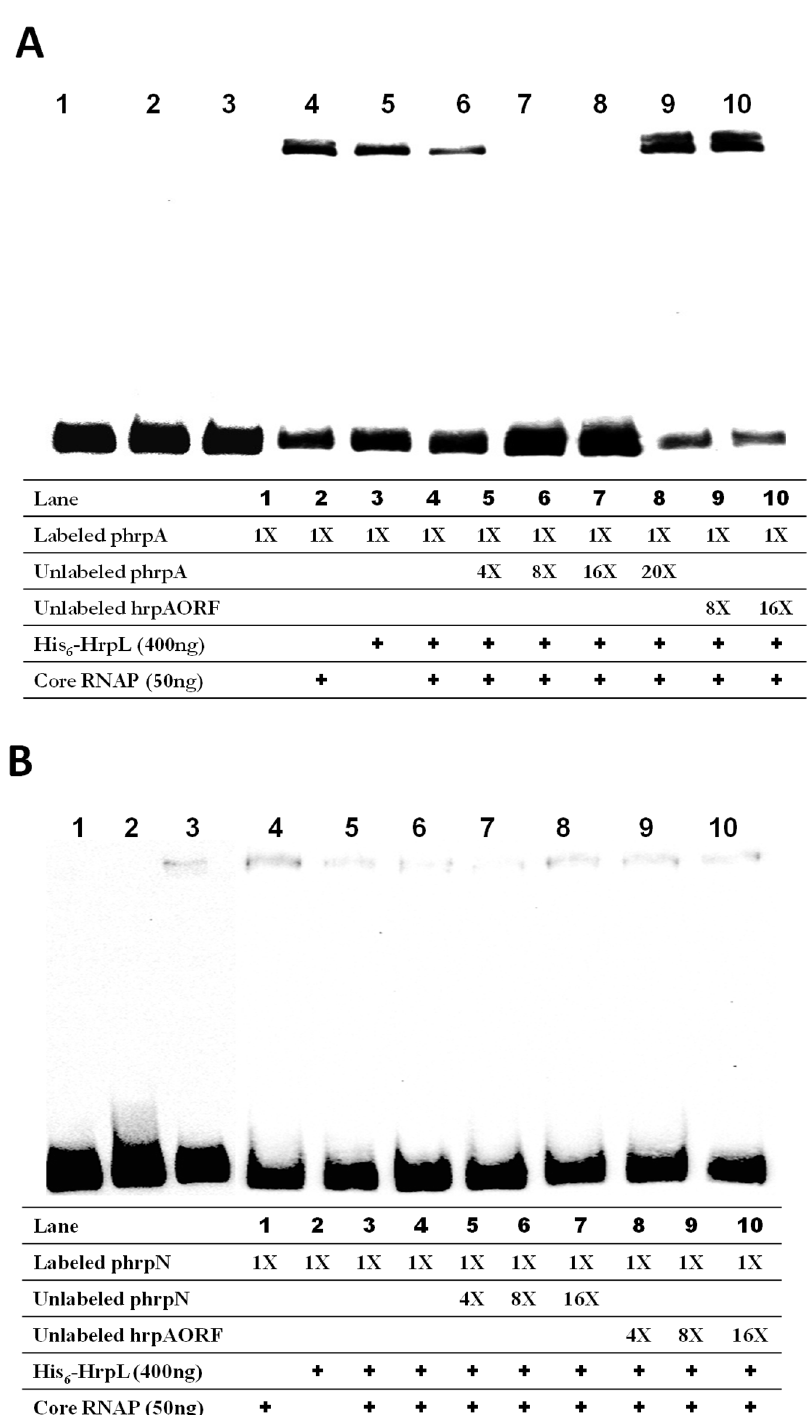
Figure 1. HrpL binds to hrp box specifically. hrpA or hrpN promoter regions containing the hrp box were amplified by PCR and labeled with digoxigenin (DIG) (Pierce, Rockford, IL). The core RNAP or His 6 -HrpL sigma factor alone were mixed with 200 fmol labeled DNA probe (1 6 ) (Lane 1–2); or core RNAP and His 6 -HrpL sigma factor mixture together with 1 6 labeled DNA probe were mixed with same unlabelled DNA probe with various concentrations up to 4000 fmol (20 6 ), or up to 3200 fmol (16 6 ) of unlabeled internal fragment of the hrpA gene. A : Labeled and unlabeled hrpA promoter region containing hrp box and the control fragments for the hrpA ORF region without hrp box (hrpAORF) were used. B : Labeled and unlabelled hrpN promoter region containing hrp box and the control fragments for the hrpA ORF region without hrp box were used.